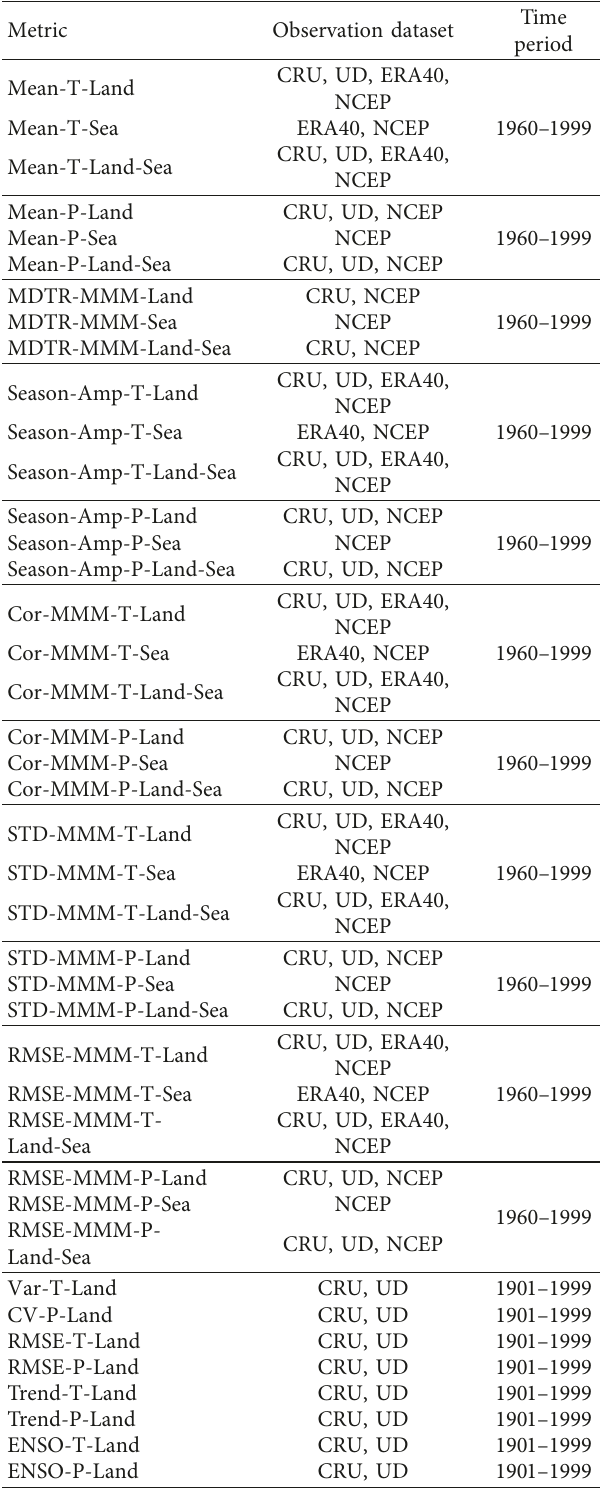
Table 3: List of performance metrics, observation datasets, and time period employed for computing each performance